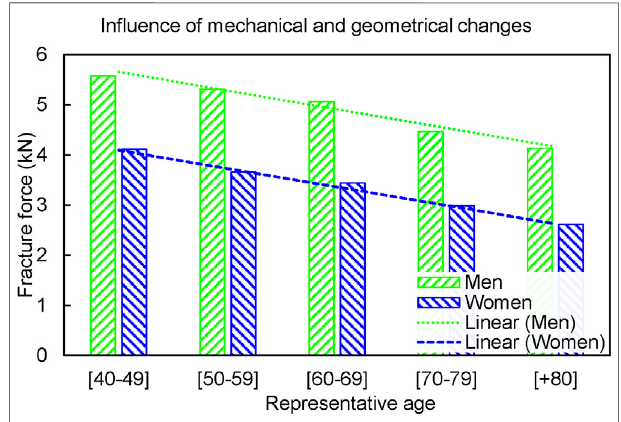
FIGURE 5 | The combined changes (MechGeomAge set) reduced the fracture forces in both men and women. The fracture forces reduced by 373.3 N per decade for men and 368.1 N per decade for women.